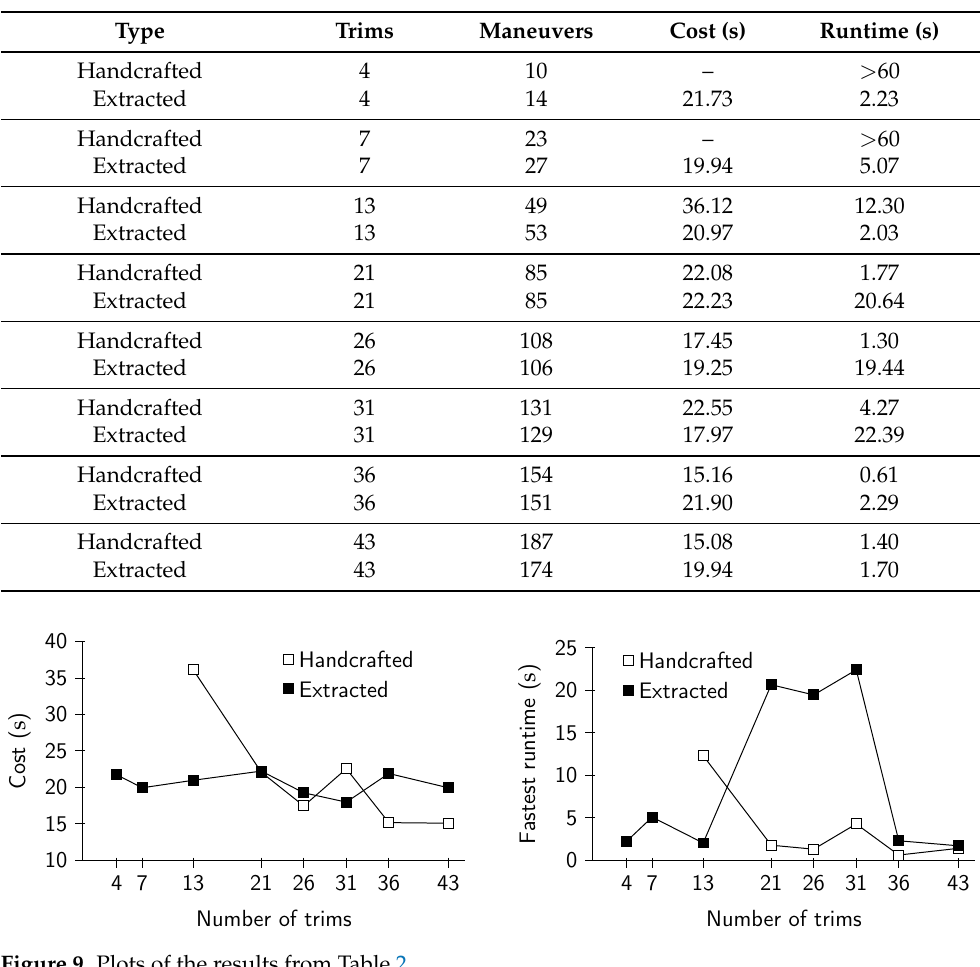
Figure 9. Plots of the results from Table